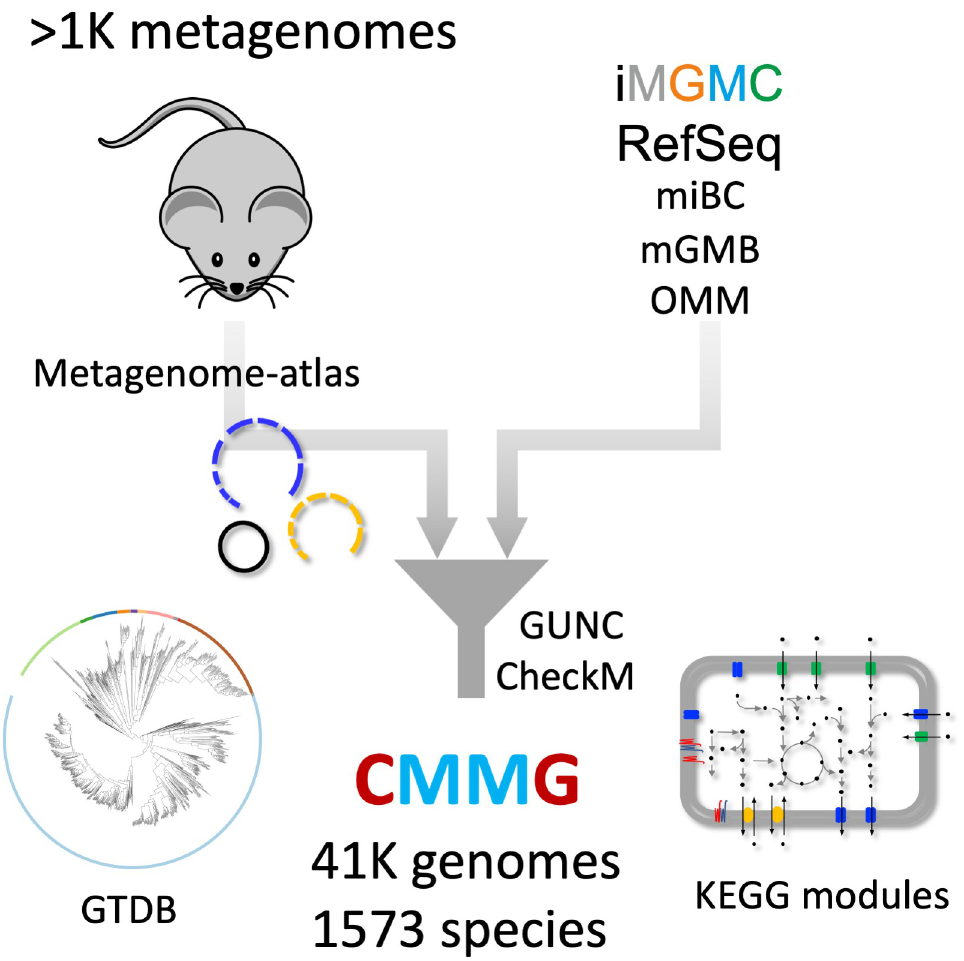
Fig 1. Scheme of the CMMG creation. | iMGMC: integrated mouse gut metagenomic catalog (660 genomes) [10]. miBC: Intestinal Bacterial Collection (53 genomes) [13]. mGMB: Mouse Gut Microbial Biobank (41 genomes) [12]. OMM: Oligo-mouse-microbiota (12 genomes) [11] GTDB: Genome Taxonomy Database [21].